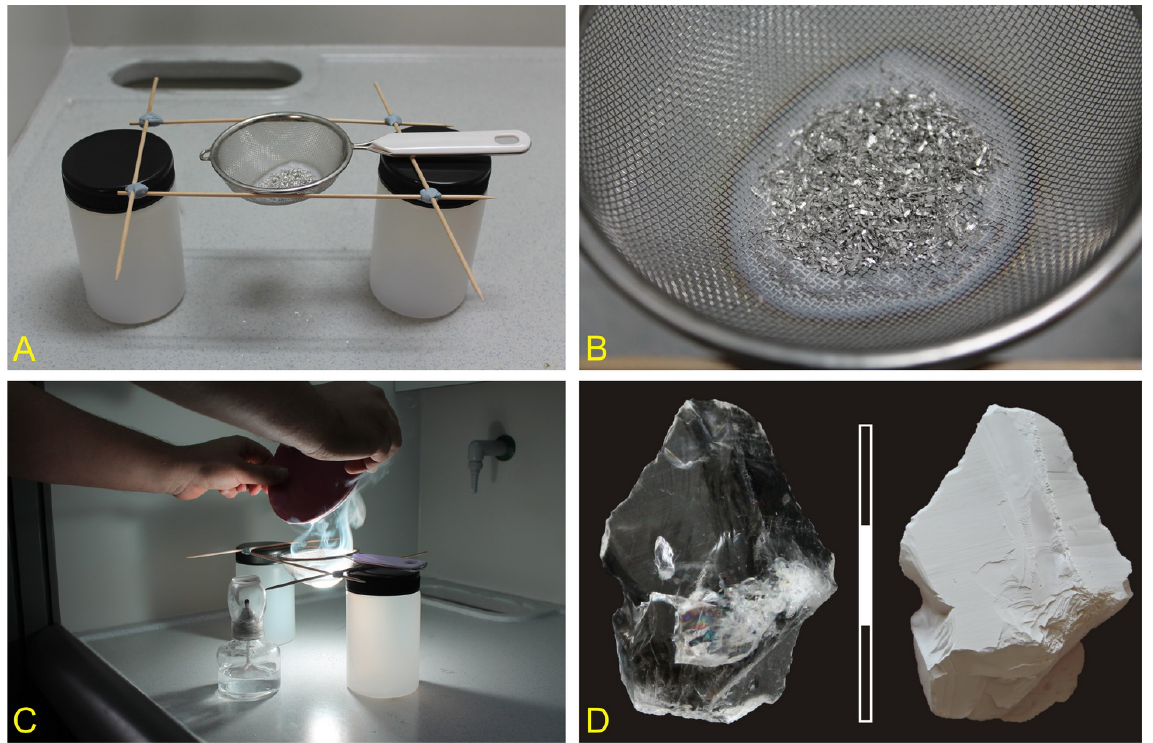
Figure 4. Process of smoking magnesium. A. Structure for the smoking process; B. Detail of the magnesium filings; C. Process of the smoking; D. The dorsal face of the tool with and without magnesium.